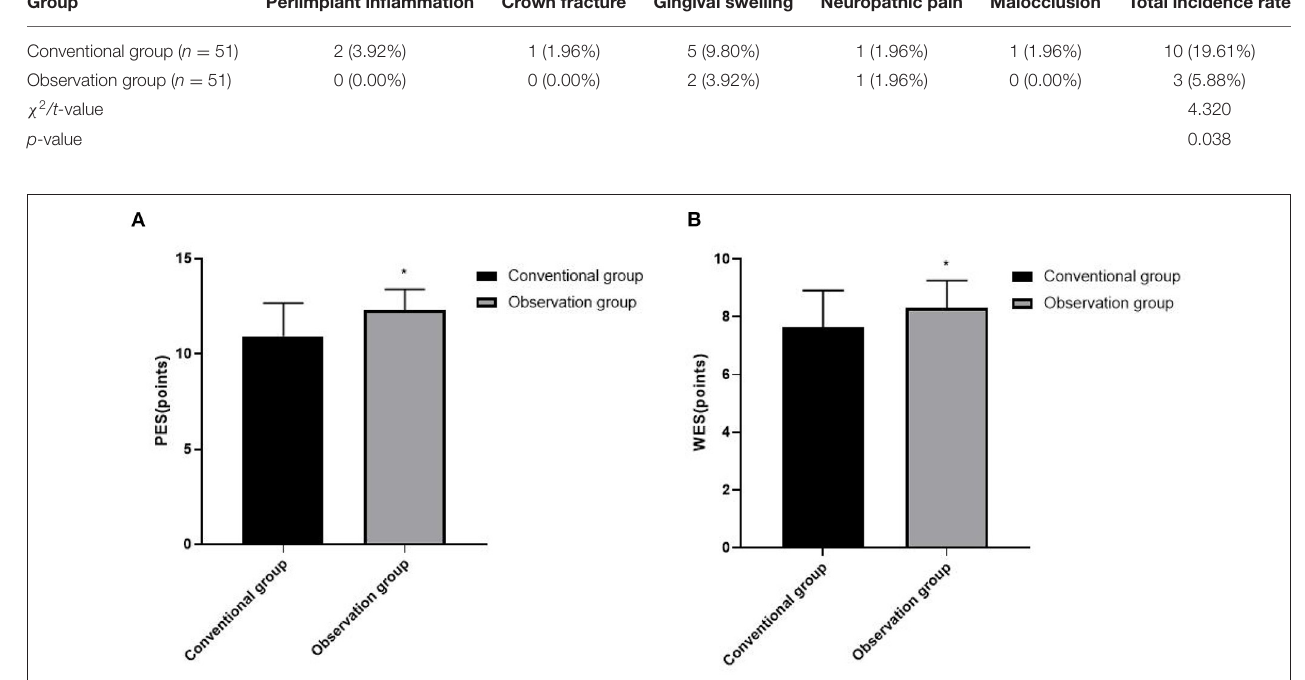
FIGURE 5 | Comparison of aesthetic effects between the two groups. (A) PES and (B) WES. Compared with the conventional group, * p < 0.05.